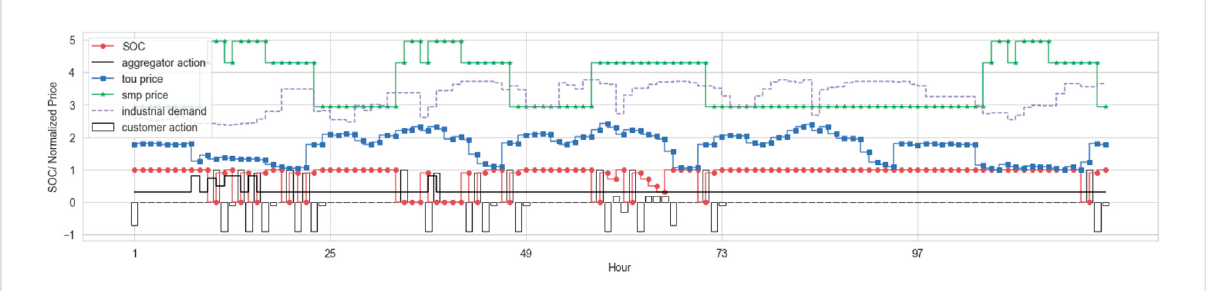
FIGURE 9 Commercial customer operation pro fi le.